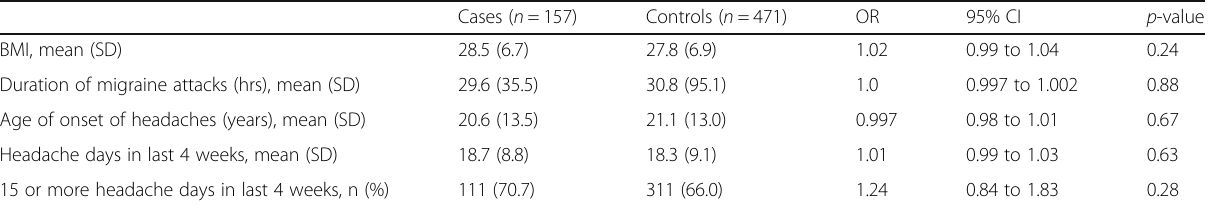
Table 1 BMI, migraine duration, age of headache onset, number of headache days last 4 weeks, and number of subjects with 15 or more headache days is last 4 weeks. OR- odds ratio, 95% CI, 95% confidence